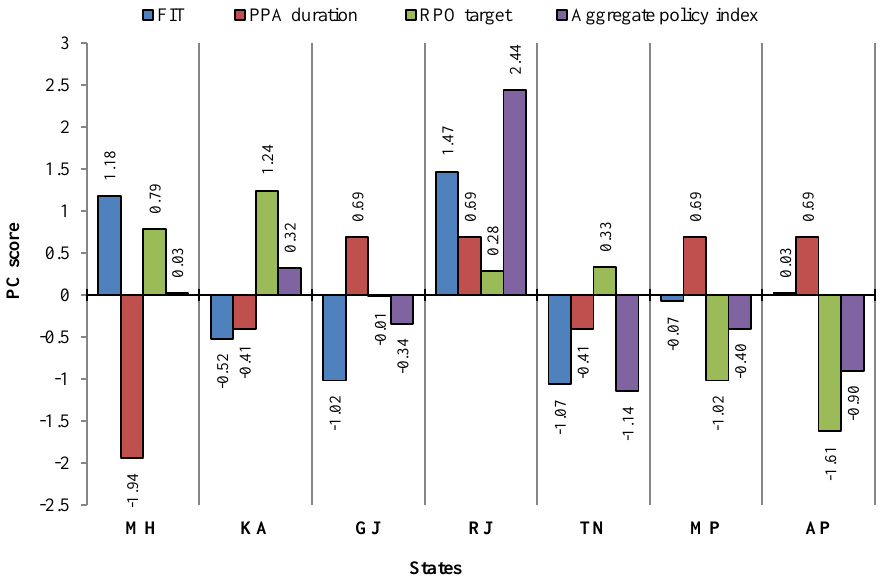
Fig. 4. PC Scores of each considered policy for each state [Source: authors’own